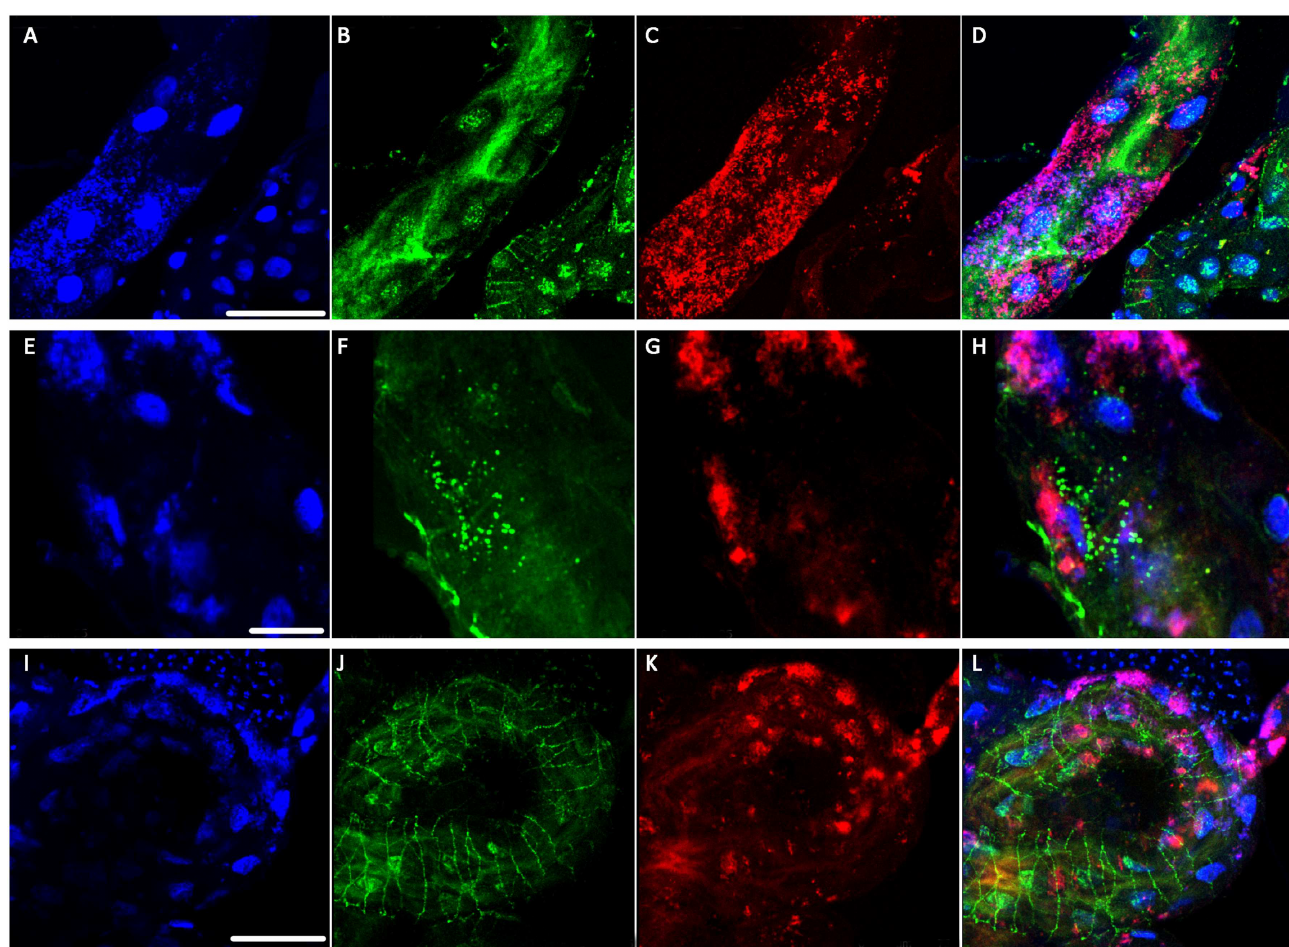
Fig 5. High magnification images of CLas and Wolbachia in CLas exposed guts visualized using fluorescence in situ hybridization (FISH) and confocal microscopy. CLas signal (Cy3) is in green, Wolbachia (Cy5) in red, and DAPI counterstaining of nucleiis in blue. (A-D) Optical cross- section of the gut visualizingCLas localization in along the brush border membraneof the gut lumen. Rarely, CLas can be seen co-localized with the DAPI signal,indicatingnuclearassociation. Wolbachia signal does not overlap with CLas signal, see overlay (D), althoughthe two bacteria are frequently observedwithin the same cell. (E-H) CLas can also be observedin puncta within cells and there is no overlap with Wolbachia in this distributioneither. (I-L) At the basal surface of the gut, CLas is frequently observedalong the actin cytoskeleton of the gut-associated muscles. Wolbachia signal is never detected in these filaments. Scale bars = A-D 25 μ m, E-H 25 μ m and I-L 75 μ m.